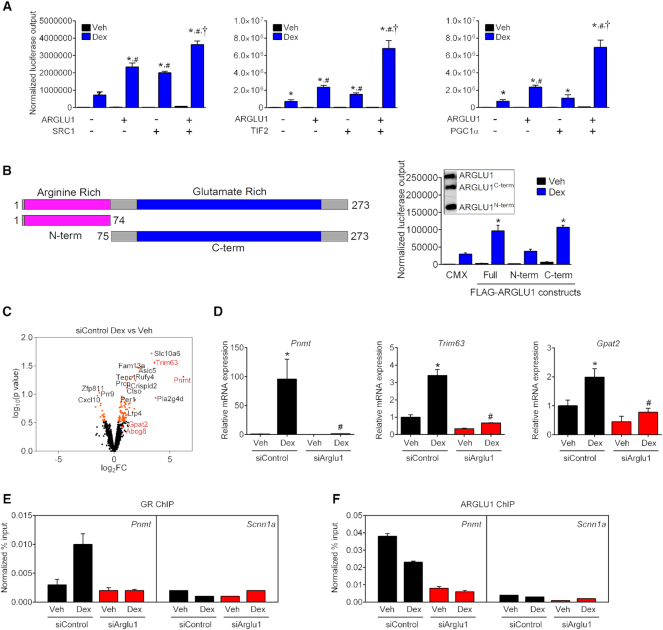
ARGLU1 is required for a full GR transcriptional response. (A) HEK293 cells were transiently transfected with CMX-hGR, MMTV-luc and ARGLU1 alone or in combination with known NR coactivators: SRC1, TIF2 and PGC1α; followed by administration of EtOH (Veh) or 100 nM Dex for 16 h. Data represent the mean ± SD (n = 3). *P < 0.05 Veh versus Dex for respective condition; #P < 0.05 relative to empty vector (CMX)-Dex; †P < 0.05 versus ARGLU1-Dex; ANOVA followed by Newman-Keuls test. (B) Schematic diagram of ARGLU1 truncations (left) and co-transfection assay of GAL4-GR/UAS-luciferase with 15 ng of ARGLU1 truncations in HEK293 cells treated with EtOH (Veh) or 100 nM Dex (right). CMX was used as a control. Data represent the mean ± SD (n = 3). Inset: FLAG-tagged full length ARGLU1 or the indicated truncation mutants were co-expressed in HEK293 cells. *P < 0.05 versus CMX-Dex; ANOVA followed by Newman–Keuls test. (C, D) Neuro-2a cells were transfected with 30 pmol of siControl and siArglu1using RNAiMax for 48 h and then treated with vehicle (EtOH) or 100 nM Dex for 4 h before RNA extraction. (C) Volcano plot of log2 fold change (log2FC) versus p value score (defined in methods from edgeR analysis) for differentially expressed genes. Orange – top 100 genes. Red – genes validated by qPCR. (D) Ligand-dependent gene expression changes (Dex vs Veh) following ARGLU1 knockdown. Data represent the mean ± SEM (n = 3). *P < 0.05 versus respective Veh, #P < 0.05 versus siControl; ANOVA followed by Newman-Keuls test. (E, F) ARGLU1-dependant ligand-induced recruitment of GR on Pnmt promoter. N2a cells were transfected with siControl or siArglu1 and treated with vehicle (EtOH) or 100 nM Dex for 1 h before crosslinking and lysis. Chromatin immunoprecipitation was performed on the extracts, using (E) anti-GR or (F) anti-ARGLU1 antibody. Data represent the mean normalized % input ± SD of one experiment (technical replicates, n = 3) repeated at least once. Scnn1a exon 2 locus served as negative control for GR recruitment. See also Supplementary Figures S4–S6.